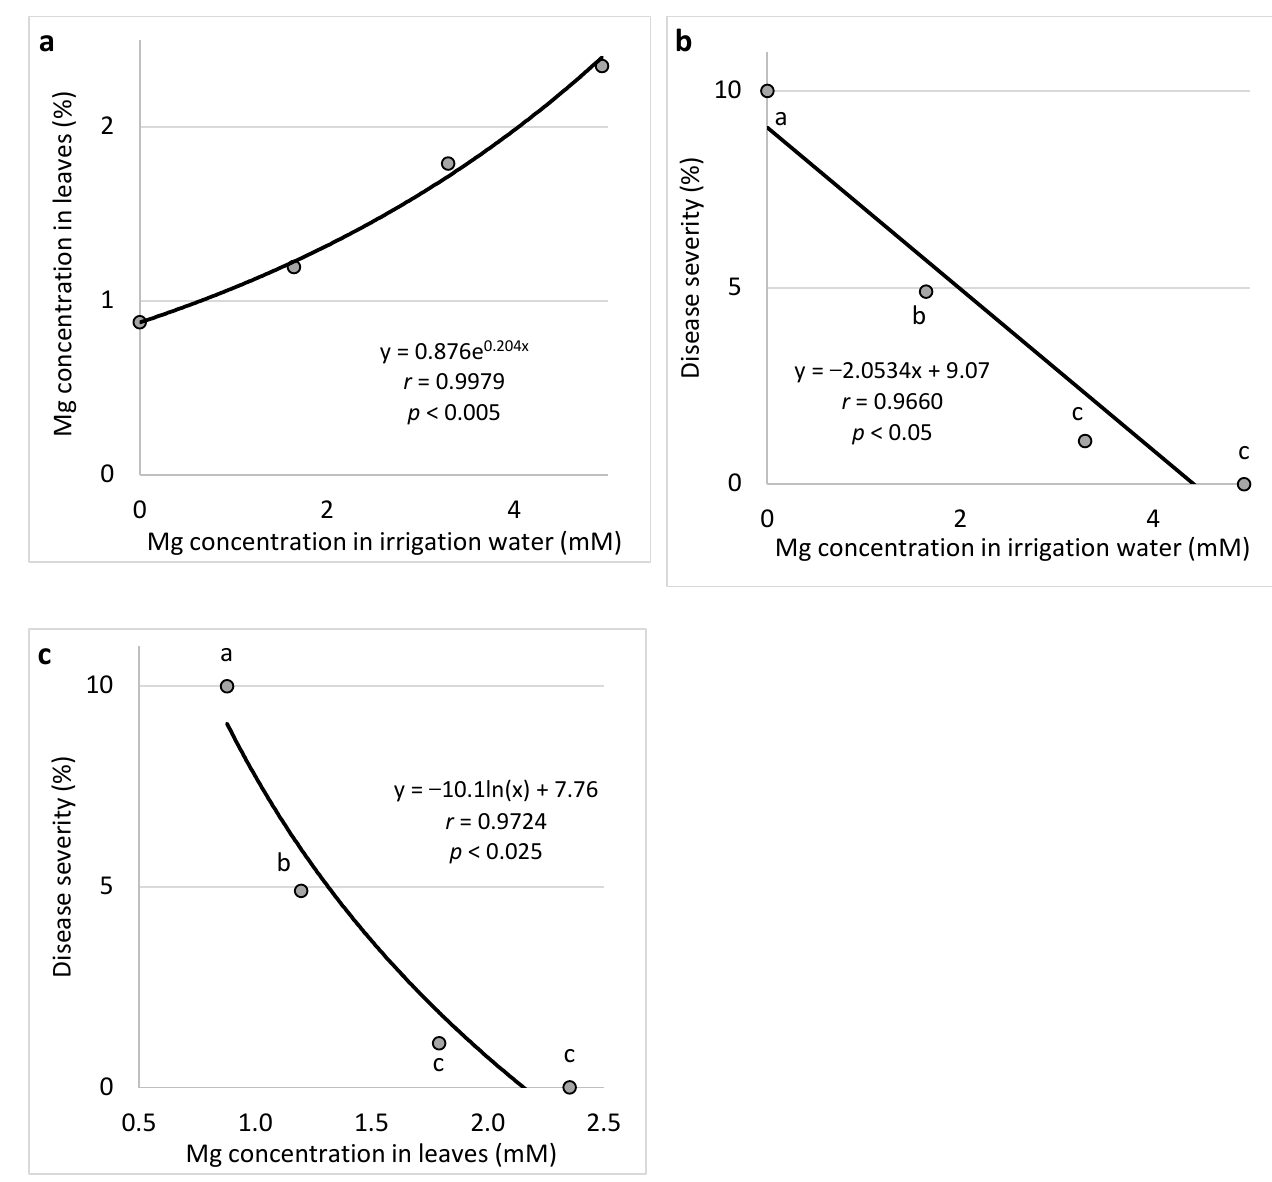
Figure 5. Effect of Mg concentration treatments in the irrigation water on cucumber downy mildew (CDM, Pseudoperonospora cubensis ). Mg concentration in the leaves is presented in relation to Mg concentration in the irrigation water ( a ), CDM severity is presented in relation to Mg concentration in the irrigation water ( b ), and CDM severity is presented in relation to the Mg concentration in the leaves ( c ). The disease was evaluated on a 0 to 100% severity scale, where 0% = healthy leaves and 100% = leaves completely covered by CDM symptoms. Values of the area under the disease progress curve (AUDPC) were calculated for 18 days after disease onset. In each graph, values for each Mg treatment followed by a common letter are significantly not different from each other according to Tukey-Kramer’s HSD test ( p ≤ 0.05). The regression formulas of the drawn trend lines are presented, and the correlation Pearson regression values ( r ) are presented along with significance levels ( p ).